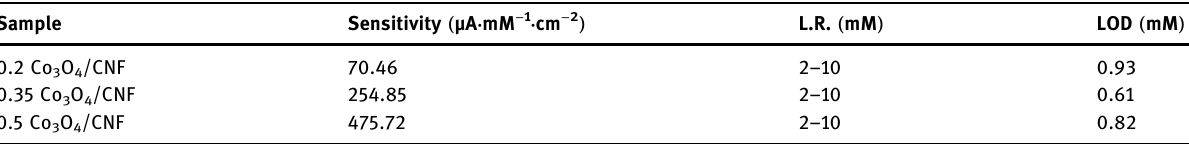
Table 2: Sensor parameters values of Co 3 O 4 /ECNF composite electrodes Sample